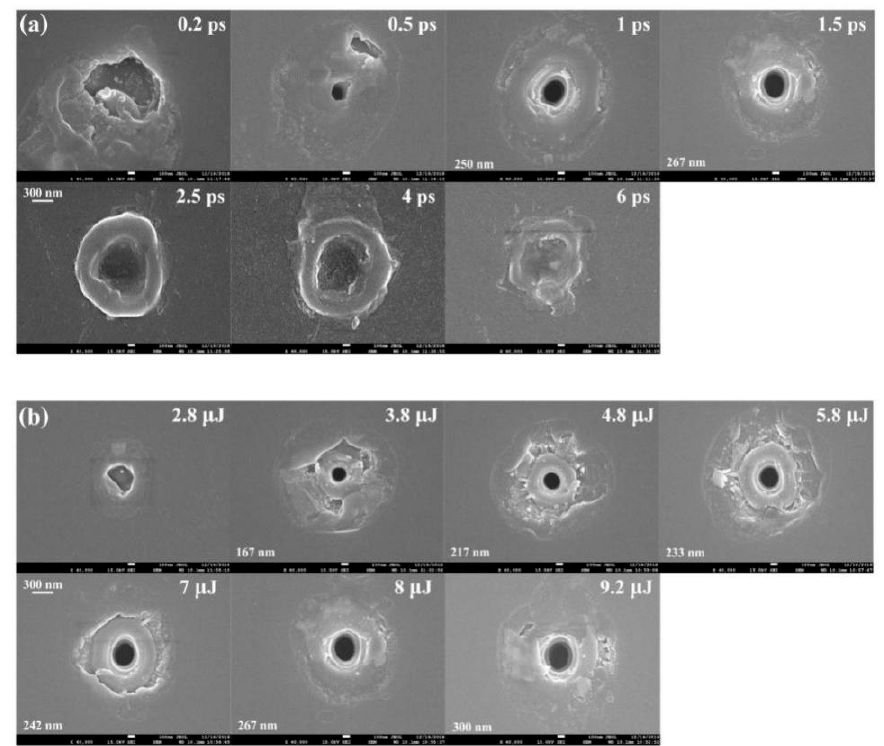
Figure 5. SEM characterization of nano-structure on the exit surface of the fused silica sample for different laser parameters. ( a ) Pulse width scan results at 8 μ J/pulse cases. ( b ) Energy scan results for a fixed pulse width of 1.5 ps. Diameters of the nano-holes have been marked in each figure. The relative spatial positions of the laser beam and the bottom surface are constant.